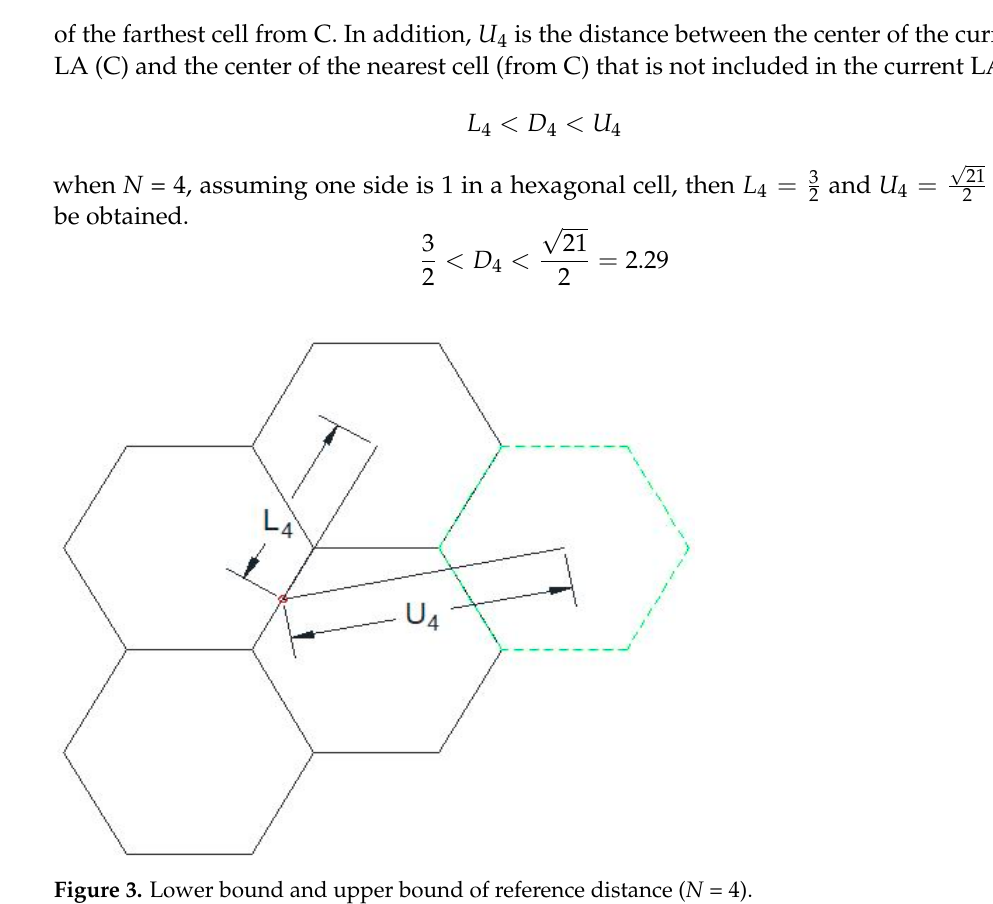
Figure 3. Lower bound and upper bound of reference distance ( N = 4).